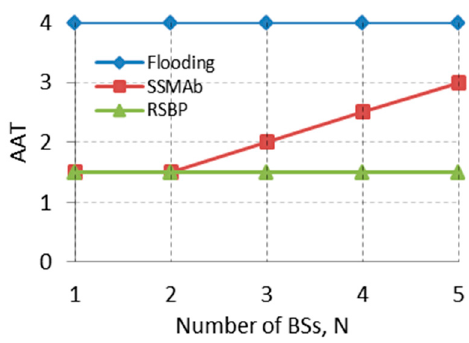
Figure 2. Comparison of average active time ( AAT ) per node for different approaches (assuming that len( BS ) = 1, H = 6 and r ≈ 0.5).